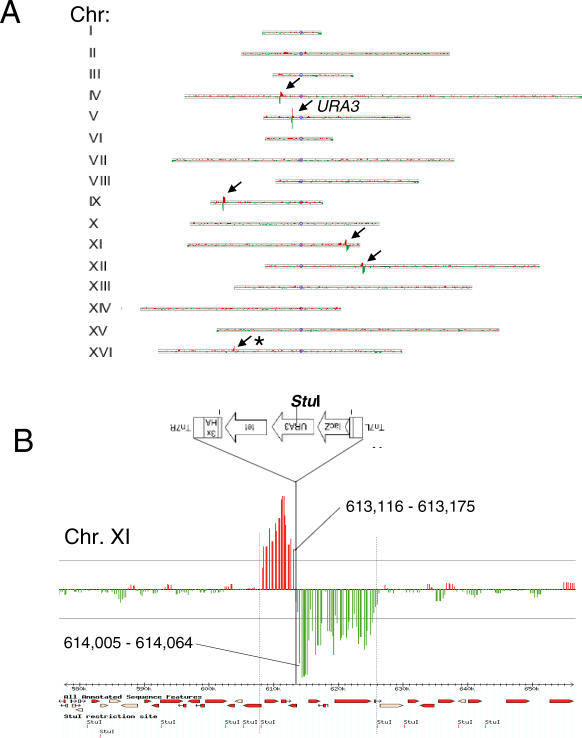
Analysis of Modified Bacterial (“Artificial”) Transposon Insertions in the S. cerevisiae Genome(A) Positions of five independent pooled artificial transposons from a yeast insertion library were determined after extracting StuI-digested yeast genomic DNA with probes designed to correspond to either strand at the 5′ or 3′ end of URA3, labeling with Cy3 and Cy5, respectively, and hybridizing to an Agilent yeast whole genome microarray. Arrows signify locations of significant differential hybridization. “URA3” indicates the actual URA3 locus on Chromosome V. The asterisk indicates an insertion on Chromosome XVI in which only the flanking region 3′ to the transposon is detected. Vertical lines above and below the horizontal for each chromosome represent the log2 ratio of hybridization intensity for Cy5 versus Cy3 at each feature along the Agilent yeast whole genome microarray. For each insertion, the actual insertion site, determined by sequencing, and the position of the first significant flanking features are as follows: Chromosome IV, 368020, and 367656–367715 and 368589–368648; Chromosome IX, 55576, and 55291–55350 and 55808–55867; Chromosome XI, 613654, and 612706–612765 and 614005–614064; Chromosome XII, 387226, and 386346–386405 and 387248–387307; and Chromosome XVI, 296609, and 296350–296409 to 297592–297651.(B) An enlargement of the region detected on Chromosome XI, showing the structure of the artificial transposon, its unique StuI site, the bases covered by the oligonucleotides in the features on either side of the transition from significant differential Cy5 labeling to Cy3 labeling, and the position of the actual insertion. The map of the region from GBrowse of SGD shows the position of StuI restriction sites in the region. Grey horizontal lines above and below the central line for each chromosome correspond to a 3-fold ratio of signal intensity. Note that the transposon inserted in opposite orientation relative to the chromosome numbering, and is therefore flipped in the figure.